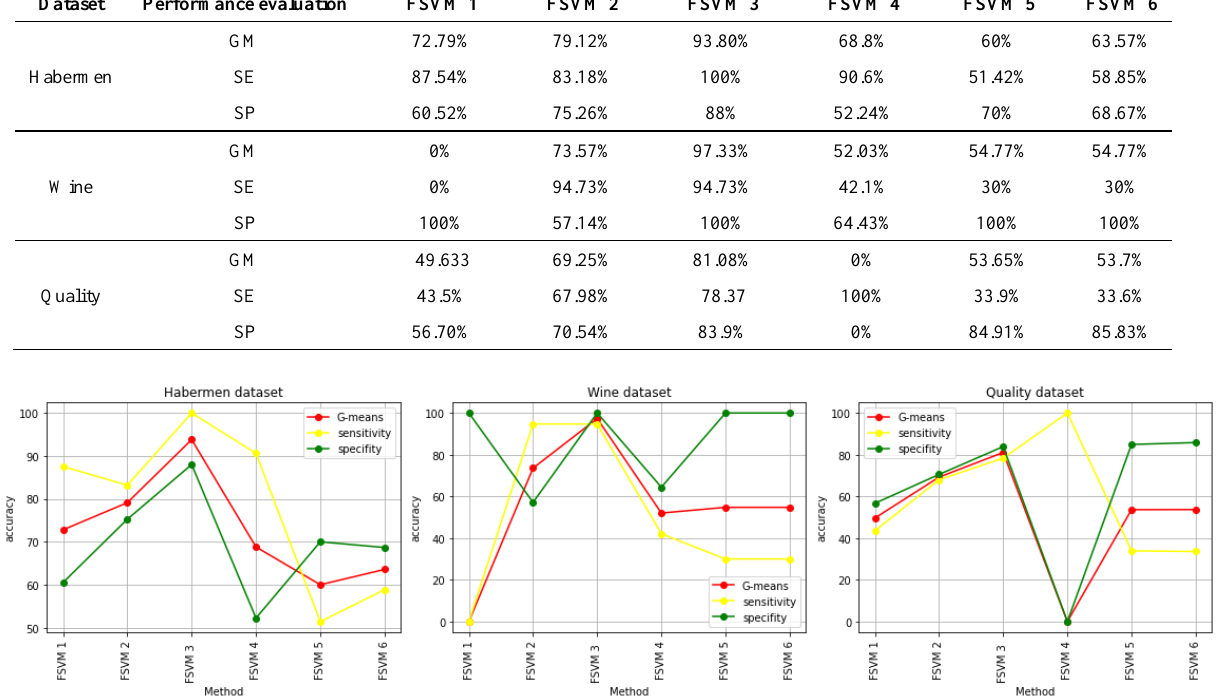
Figure 3. Model Performance Evaluation Graph for Wine and Quality